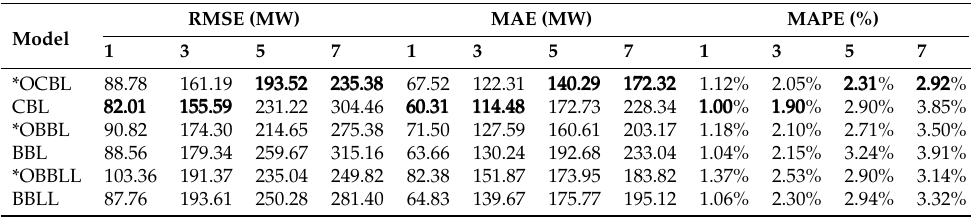
Table 3. Experimental results: average RMSE, MAE, and MAPE in 2020. * indicates the model contains NODE block.